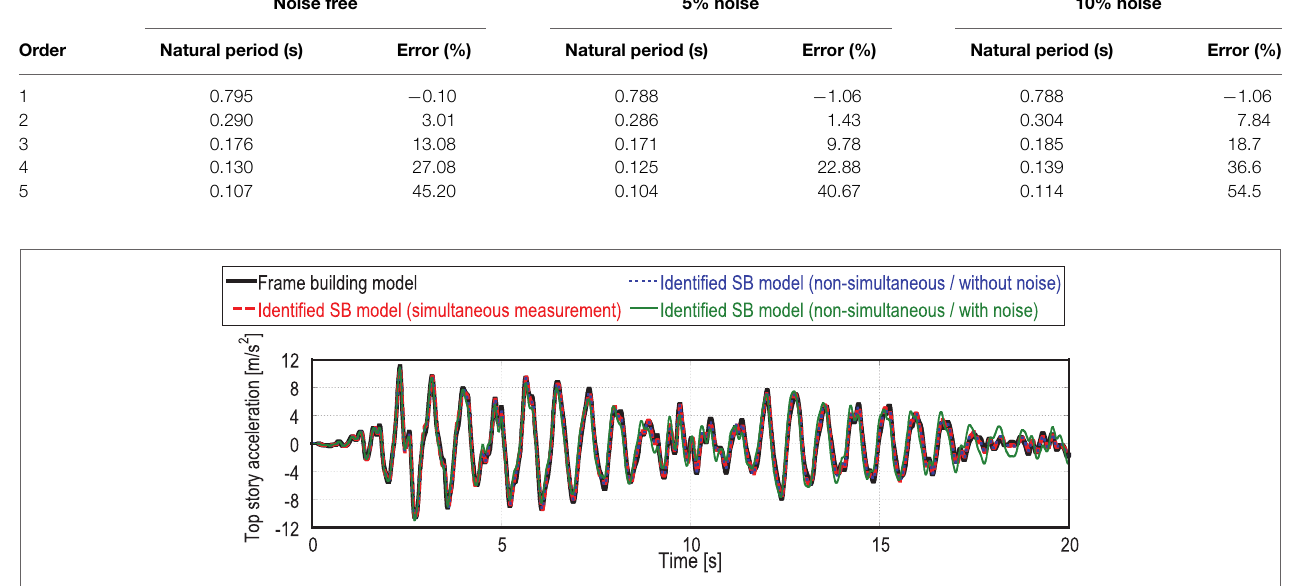
FIGURE 10 | Comparison of top-story horizontal accelerations in identified shear-bending model (SB model) under El Centro NS (1940).